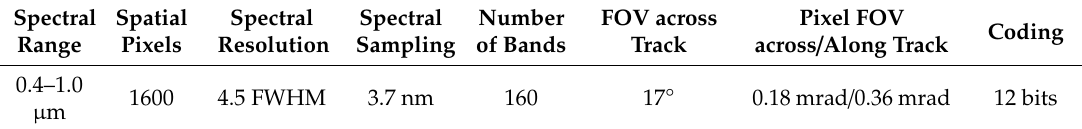
Table 1. Characteristics of the HySpex Visible Near Infra-Red (VNIR)-1600 sensor.